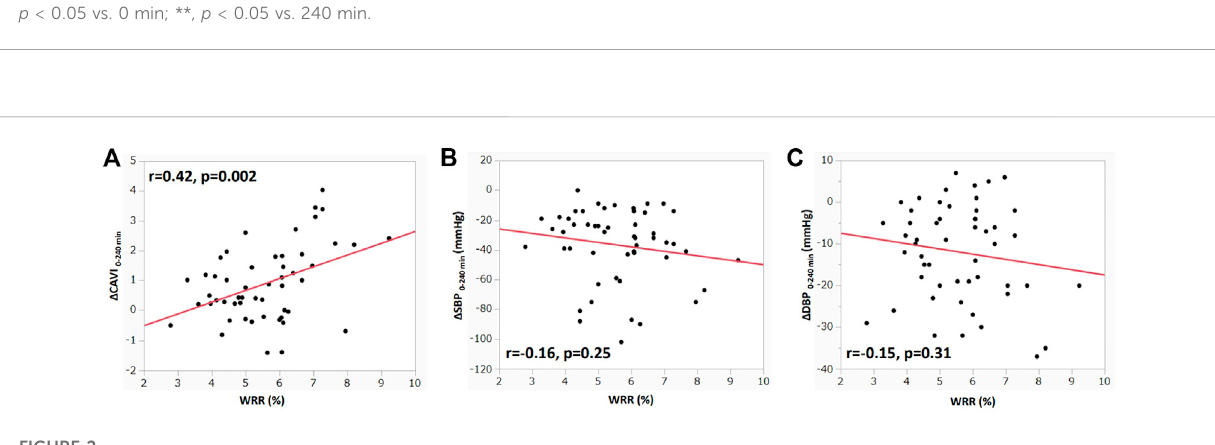
Changes in BP, CAVI, and other hemodynamic parameters during hemodialysis (A) Changes in BP, CAVI, and haPWV during hemodialysis. (B) Changes in CO, HR, SV, and SVR during hemodialysis. Data are shown as median (interquartile range). White bars, median; boxes, interquartile range; whisker, ranges excluding statistical outliers; plots, statistical outliers. SBP, systolic blood pressure; DBP, diastolic blood pressure; CAVI, cardio – ankle vascular index; haPWV, heart – ankle pulsewave velocity; CO,cardiac output; HR, heartrate; SV, stroke volume; SVR, systemic vascular resistance. *,